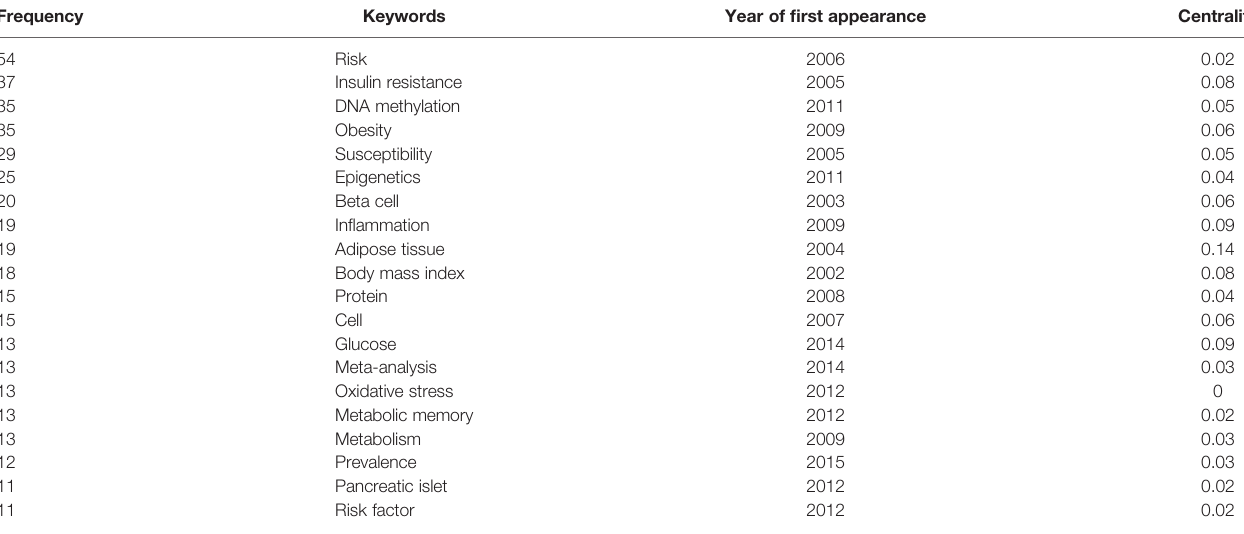
Figure 5C . The keywords were ranked based on the strength of bursts. Variant (in cluster #4) and genome-wide analysis (in cluster #5) received the highest bursting attention across the entire span. In the early years, investigating the genetic basis of insulin-dependent diabetes mellitus (in cluster #3) was one of the most important goals. Recently, there has been a growing interest in diabetes-related complications, including nephropathy (in cluster #0), and novel mechanisms in the development of the